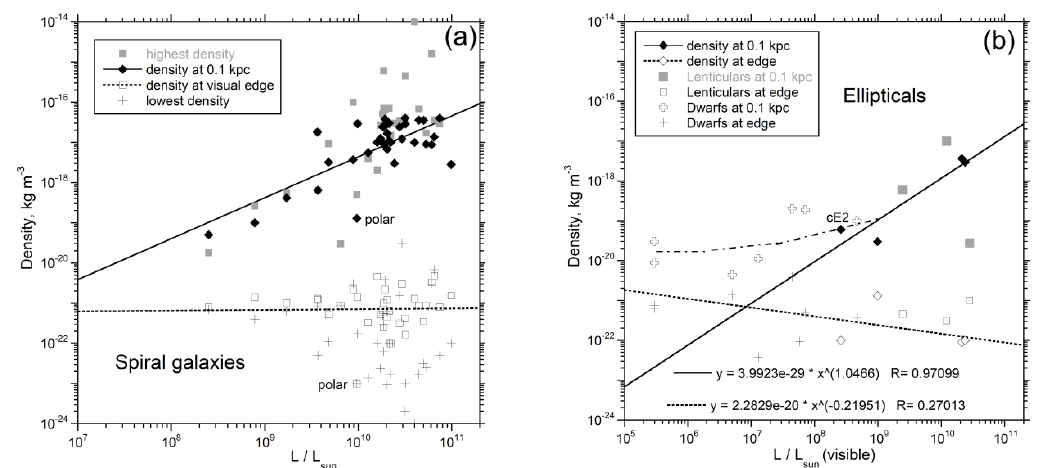
Figure 12. Dependence of density at various galactic positions on the visible luminosity of the galaxy: ( a ) Data for spirals and the polar-ring galaxy; ( b ) Other galaxy types, with a wider range of luminosity. The dwarf spheroidals show a flat dependence (dash-dotted curve). For the smallest galaxies, the average density is ~10 − 21 kg m − 3 , i.e., where trends for the large spirals converge.